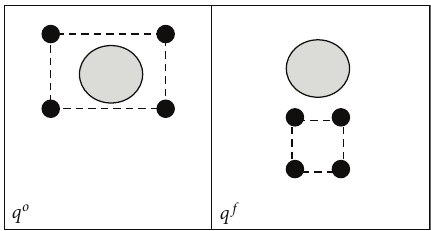
Figure 2: Geometry of the line-of-sight problem, required to compute φ los ij